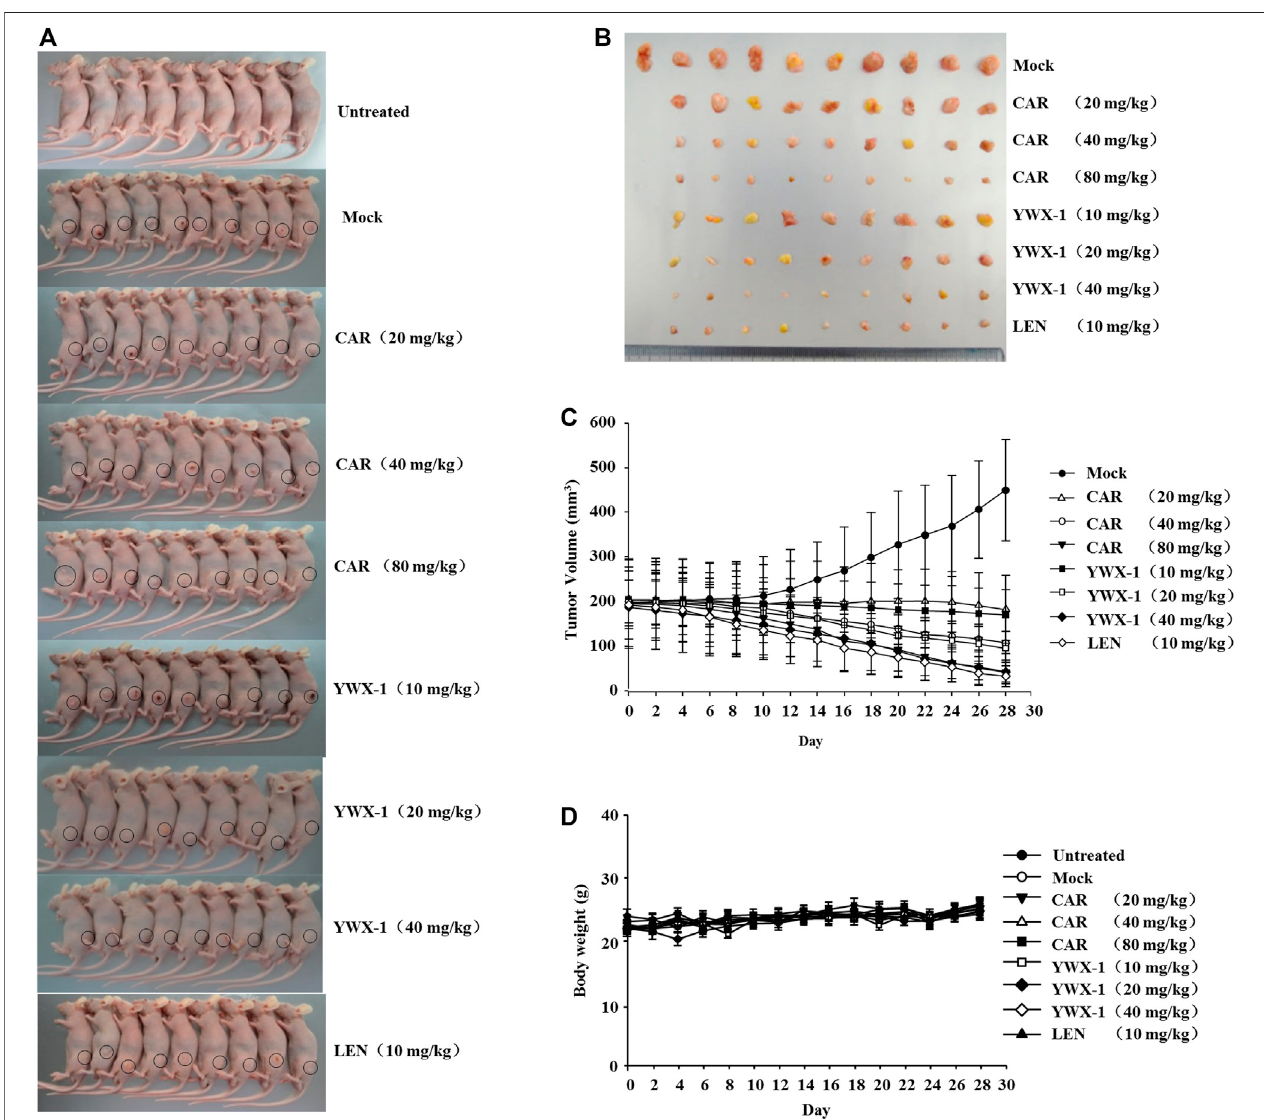
FIGURE 9 | Carrimycin (CAR) and monomeric isovalerylspiramycin I (YWX-1) inhibit the growth of SK-Hep1 cells in a subcutaneous xenograft tumor model. (A) Representative images of xenografts. (B) The representative tumor was harvested 24 h after the last treatment and the isolated tumors were photographed. (C) SK- Hep1 cells were implanted subcutaneously in the fl anks of nude mice. Tumor volume was calculated every 2 days using the equation: (width) 2 × length/2. (D) The bodyweight of each group of mice was measured using a digital balance.